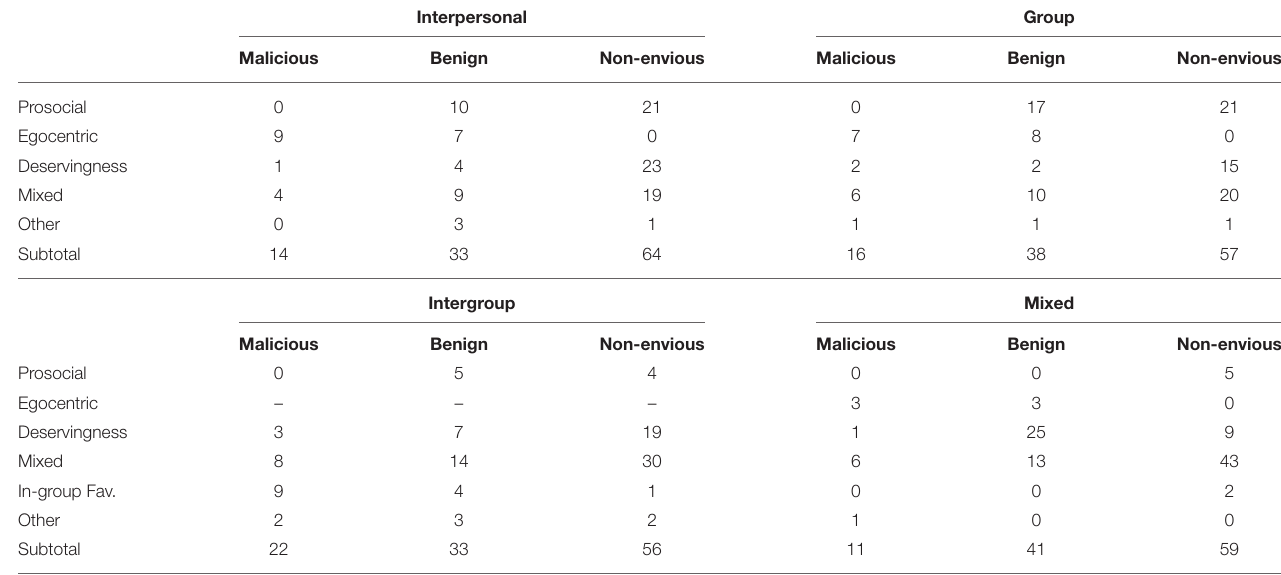
TABLE 8 | Frequencies of the justification categories in the three types of allocation for the four experimental